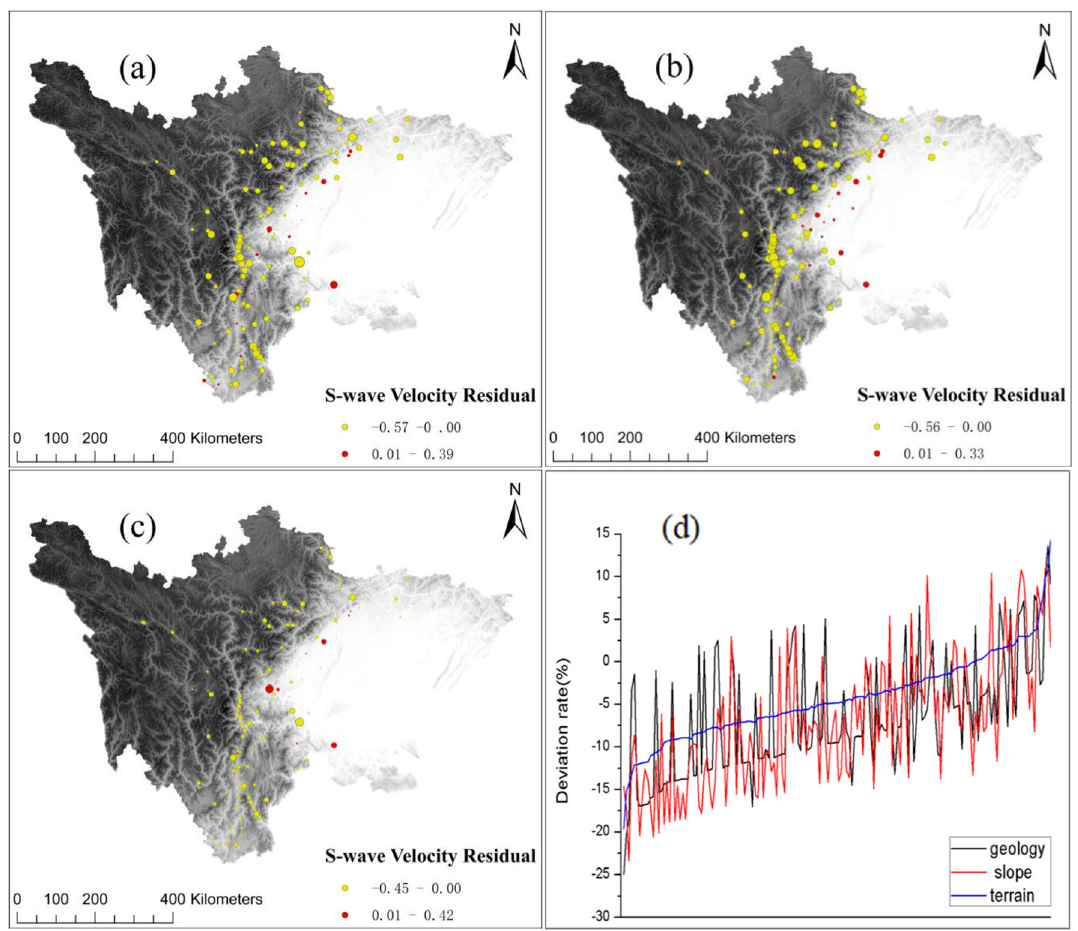
Fig. 4 Residuals between estimated logV s30 values using the a geol- ogy-based approach, b topographic slope-based approach, and c terrain-based approach and the measured logV s30 values at the 160 stations in Sichuan Province. Stations in yellow indicate where the V s30 value was overestimated; stations in red indicate where the